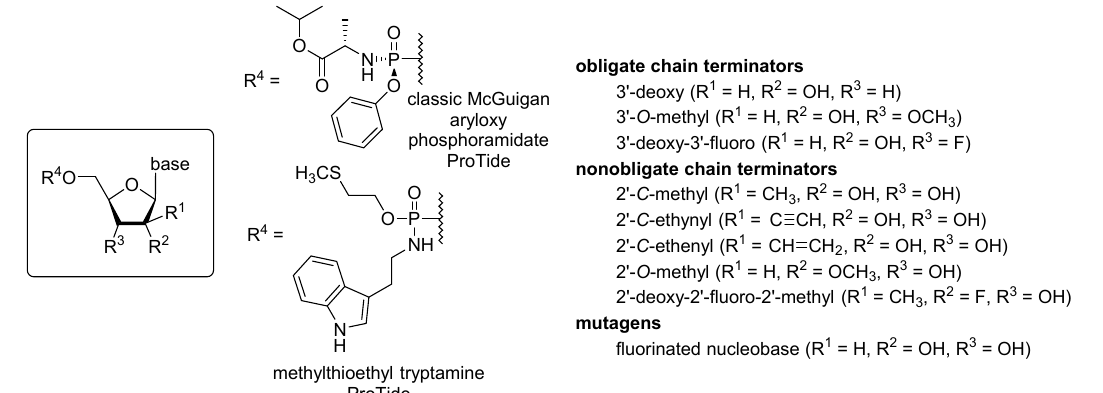
Figure 1. Design and structure of nucleotide analogue inhibitors tested against Zika virus (ZIKV) in this study.